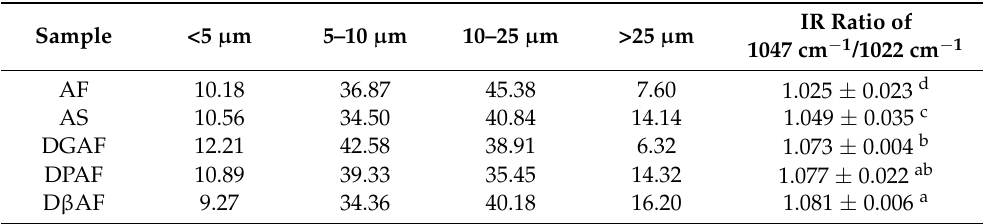
Table 2. Particle size distribution (%) and short-range molecular order of AF and after removal of non-starch nutrients.